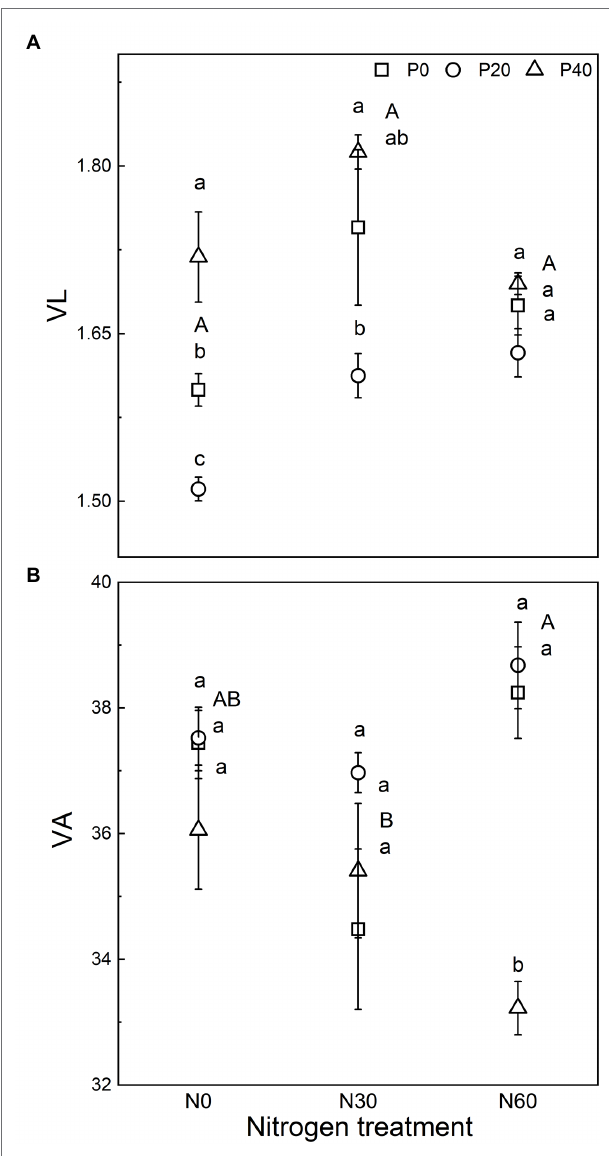
Different lowercase letters indicate significant differences between P addition rates at identical N addition rates. Different capital letters indicate significant differences between N addition rates at identical P addition rates ( p <